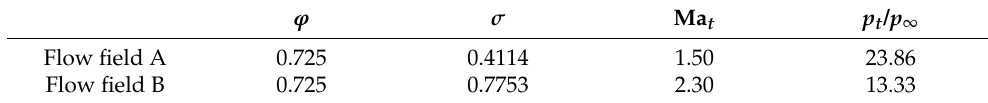
Table 1. Comparison of main aerodynamic parameters at the throat under two types of flow fields.